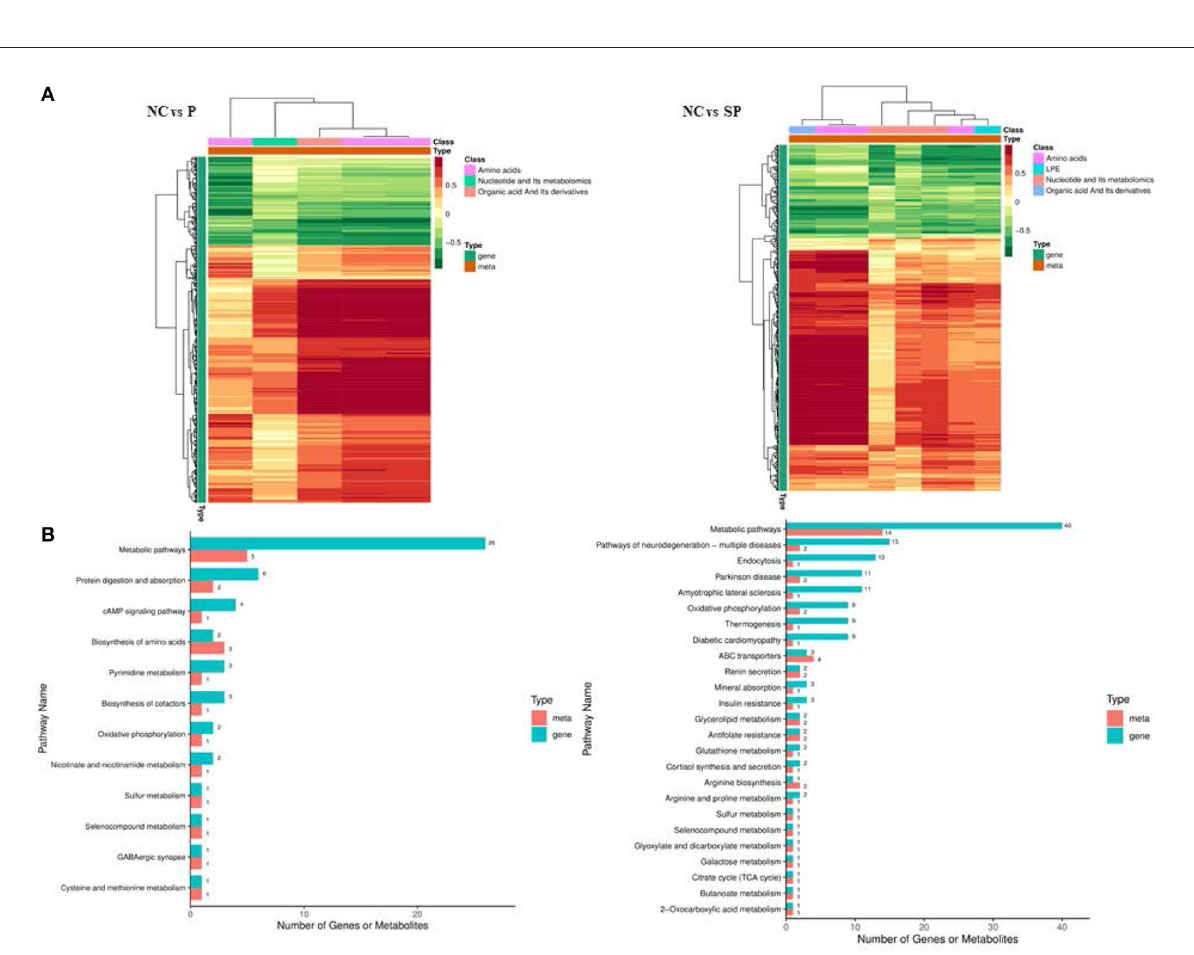
FIGURE9 Combined analysis results of DEGs and differential metabolites. (A) Correlation cluster heatmap of differentially expressed genes and differential metabolites; (B) Bar chart of differentially expressed genes and differential metabolites KEGG